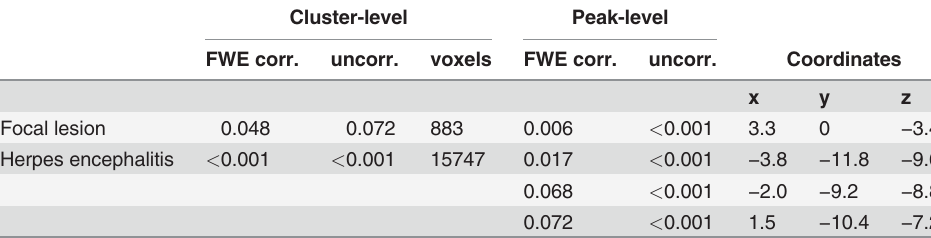
Table 8. Voxel-based analysis. Cluster-level Peak-level CoordinatesFWE corr. uncorr. voxels FWE corr. uncorr. x y z Focal lesion 0.048 0.072 883 0.006 < 0.001 3.3 0 − 3.4 Herpes encephalitis < 0.001 < 0.001 15747 0.017 < 0.001 − 3.8 − 11.8 − 9.6 0.068 < 0.001 − 2.0 − 9.2 − 8.8 0.072 < 0.001 1.5 − 10.4 − 7.2 Increased uptake of [ 11 C]PK11195 in the intervention group as compared to the healthy rats. For the focal lesion test, Sprague-Dawley rats were divided in a healthy control group ( n = 11) and rats stereotaxic injected with saline ( n = 10). For the herpes encephalitis model, Wistar rats were divided in a healthy group ( n = 19) and infected rats ( n = 14). For the interpretation of group differences, T -maps data were interrogated at p = 0.001 (uncorrected) and an extent threshold of 200 voxels. Only cluster with p < 0.05 family-wise error (FWE) corrected were considered signi fi cant.